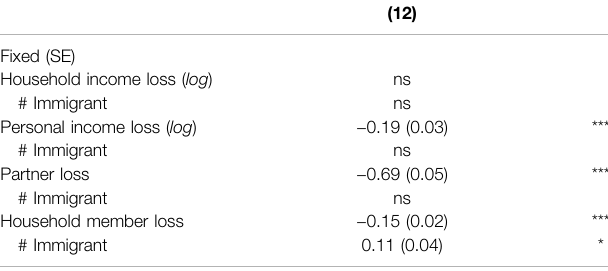
TABLE 5 | The resilience of immigrants to recent loss experiences.